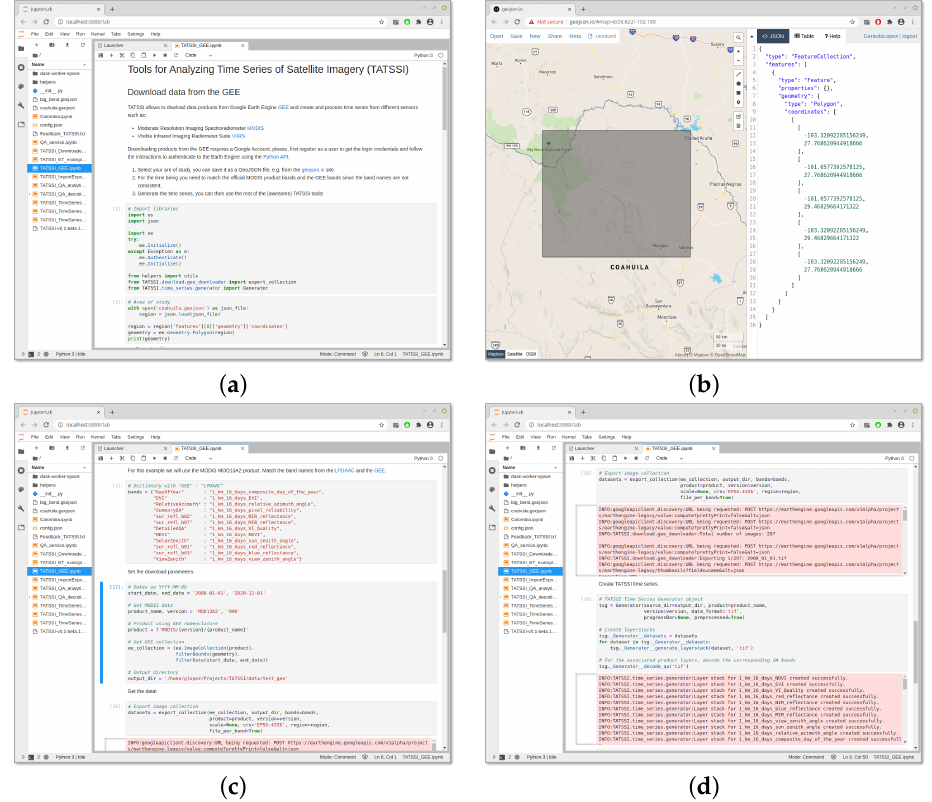
Figure 4. The TATSSI Jupyter Notebook interface used to download and generate a time series for an area of interest (AOI) from the MOD13A2 product. ( a ) Importing libraries and setting up the Google Earth Engine (GEE). ( b ) Defining the AOI from a GeoJSON feature. ( c ) The matching of scientific dataset (SDS) names. ( d ) Downloading and generating time